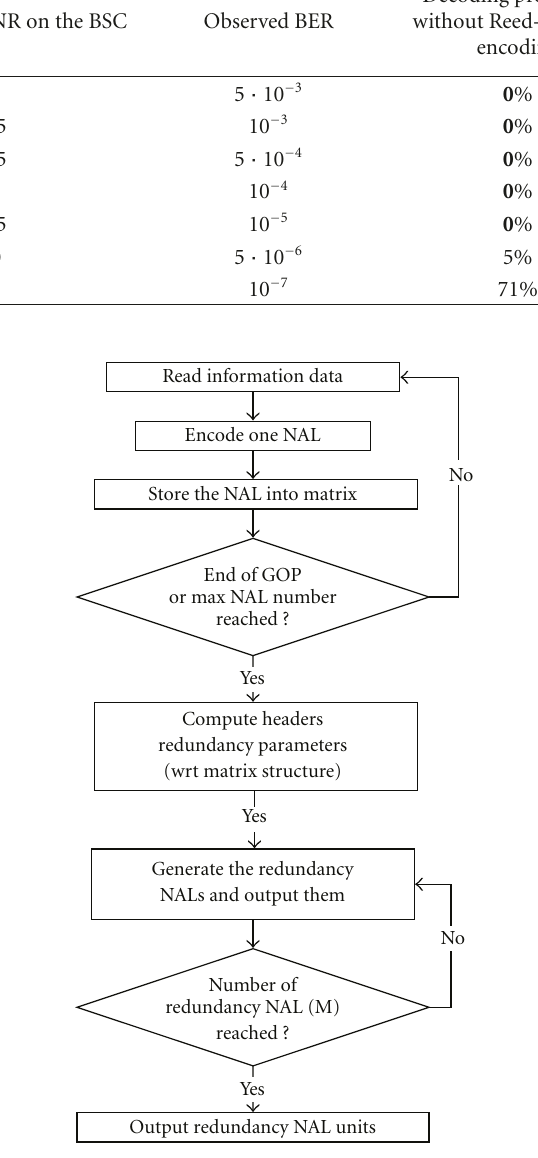
Figure 7: N / M redundancy encoding